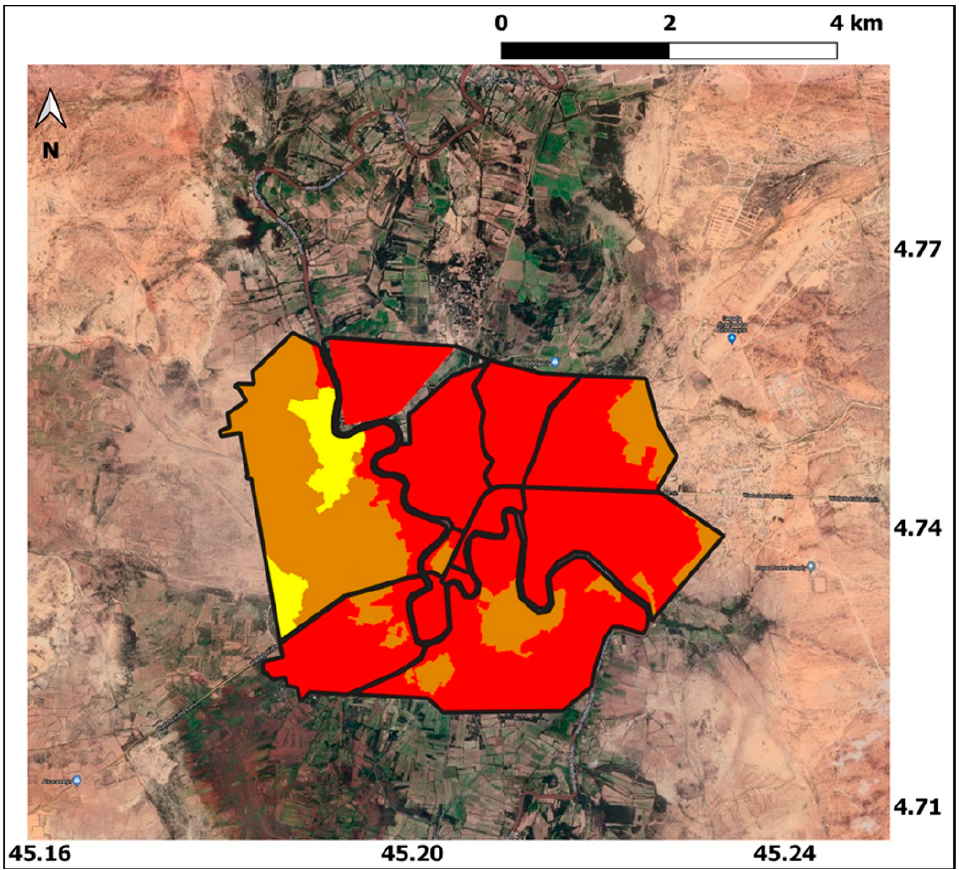
Figure 4. Reference map derived from the shapefile made available by UNOSAT to provide information about the flood that occurred in Beletweyne in April–May 2018. The boundaries of the districts shown in Figure 1 are highlighted in black.